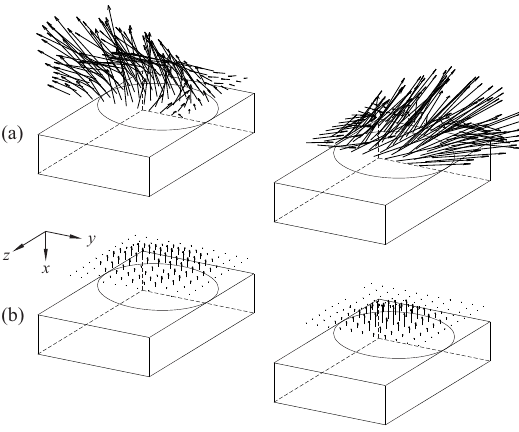
Figure 10: ⃗ I for h / λ = 0.18 . (a) primary, (b) residual on plane